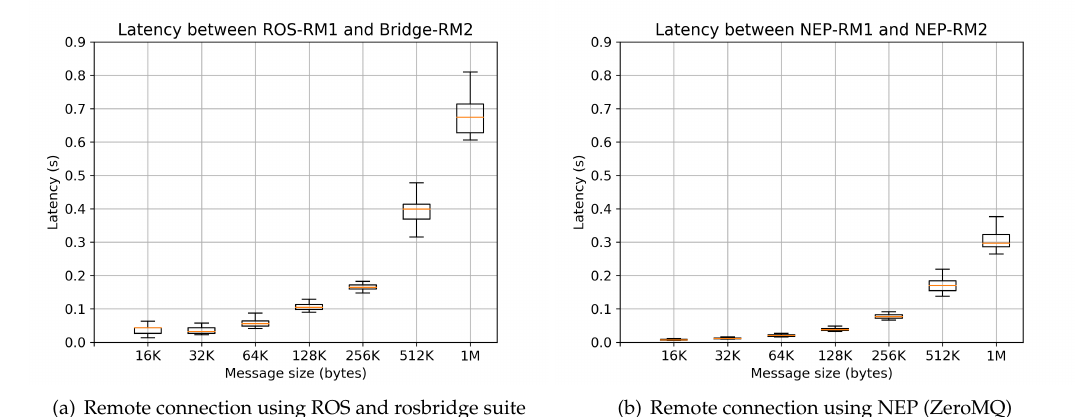
Figure 9. Latency results in scenario R-Remote; comparisons between NEP and ROS-rosbridge using nodes written in Python 2 and Python 3 executed in different machines, which are connected over the same Wifi network.